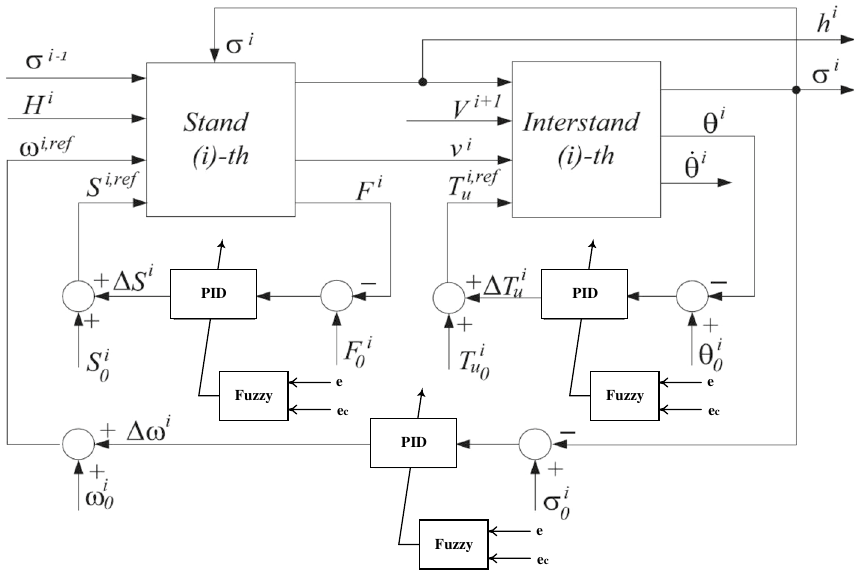
Fig. 12 Fuzzy-PID control scheme